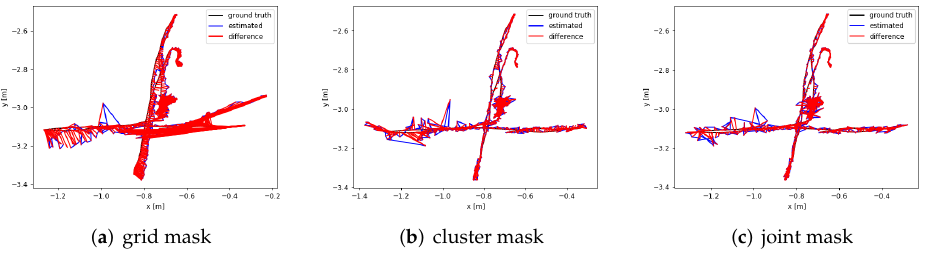
Figure 5. Camera trajectory image of the removal effect of three mask images on dynamic